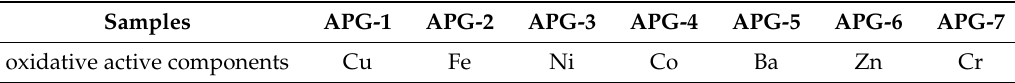
Table 4. The different oxidative active components in the different samples.